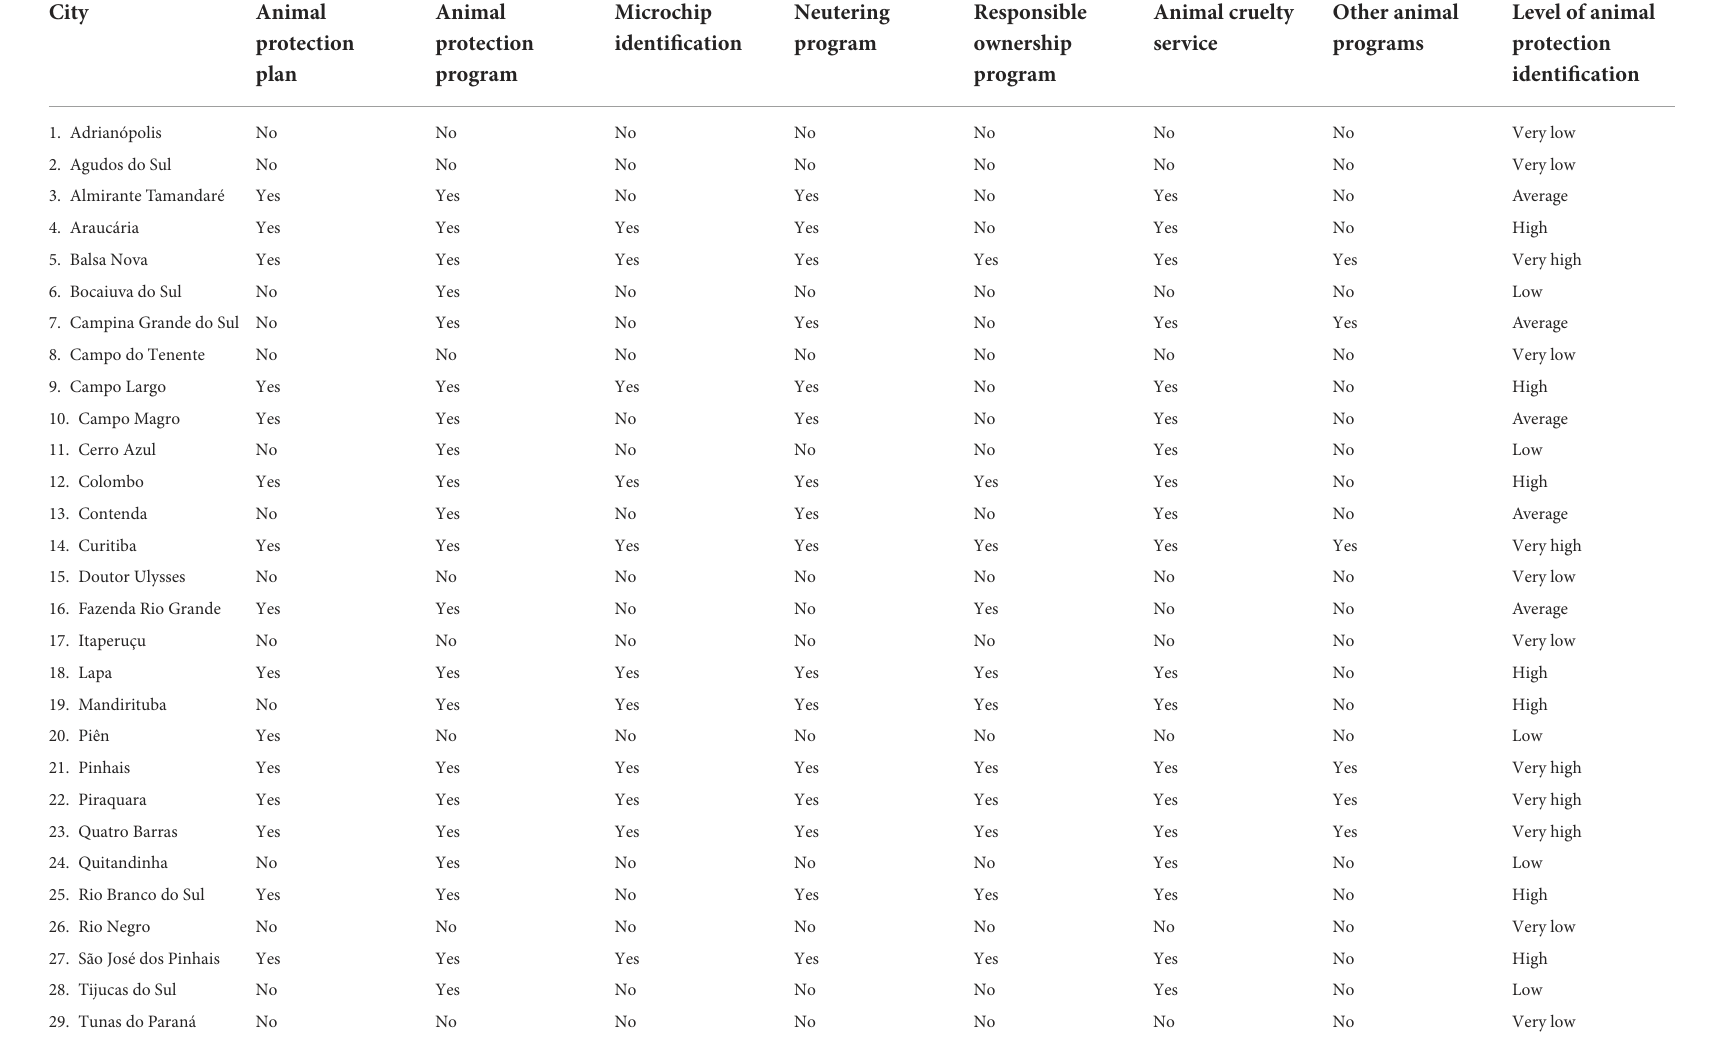
TABLE 2 Indicators and levels of animal protection identification out of 29 cities included in the metropolitan area of Curitiba, Parana State, Brazil * .